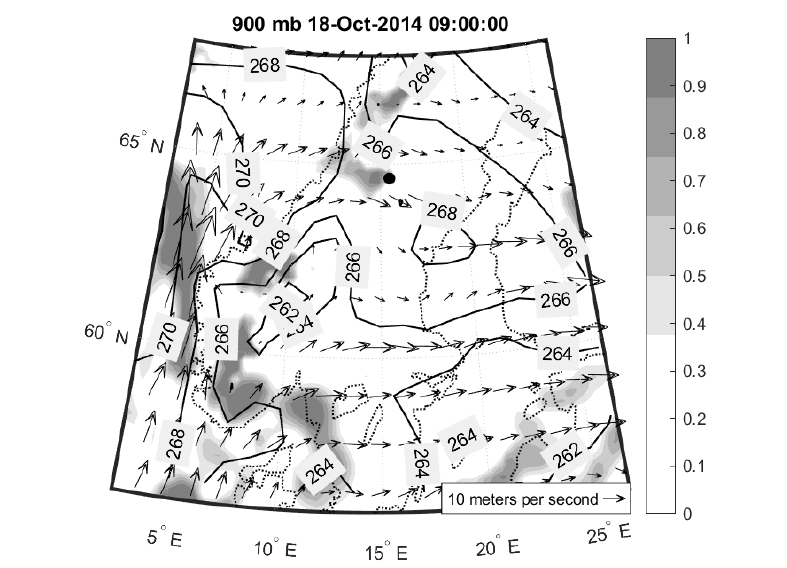
Figure 9. ECMWF ERA5 reanalysis: Cloud fraction (shading), wind vectors (m/s), and temperature (K; contours) at 900 millibars at 09:00 UTC 18 October 2014 over Scandinavia. MUSC was initialized at the location of the black